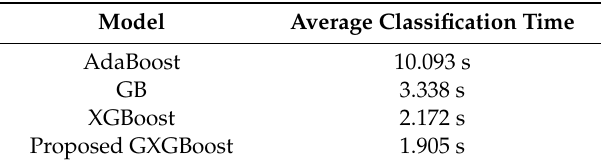
Table 12. Average execution time of classification in seconds (s).